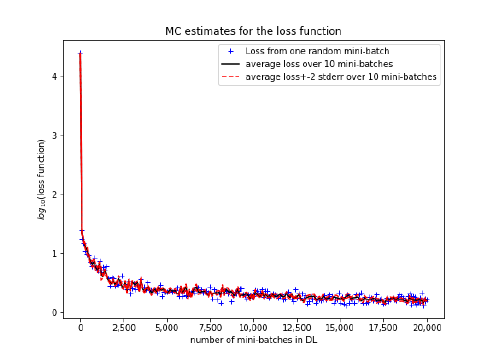
Figure 2. Loss function over 20,000 mini-batches for long call combination for batch-variance method with exact backward step. Loss functions for the other variants look very similar. Batch size